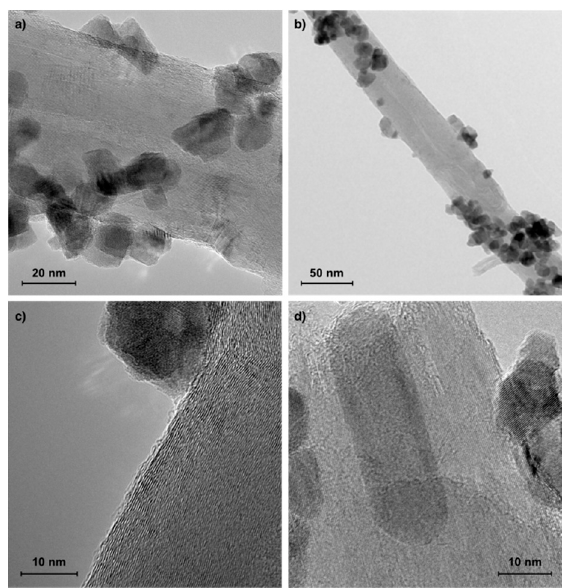
Figure 9. SEM of Ni/CeZrO 2 ( a ) before and ( b ‒ d ) after CH 4 decomposition at T = 700 °C under flowing 10 vol.% CH 4 /Ar for t = 3 h.